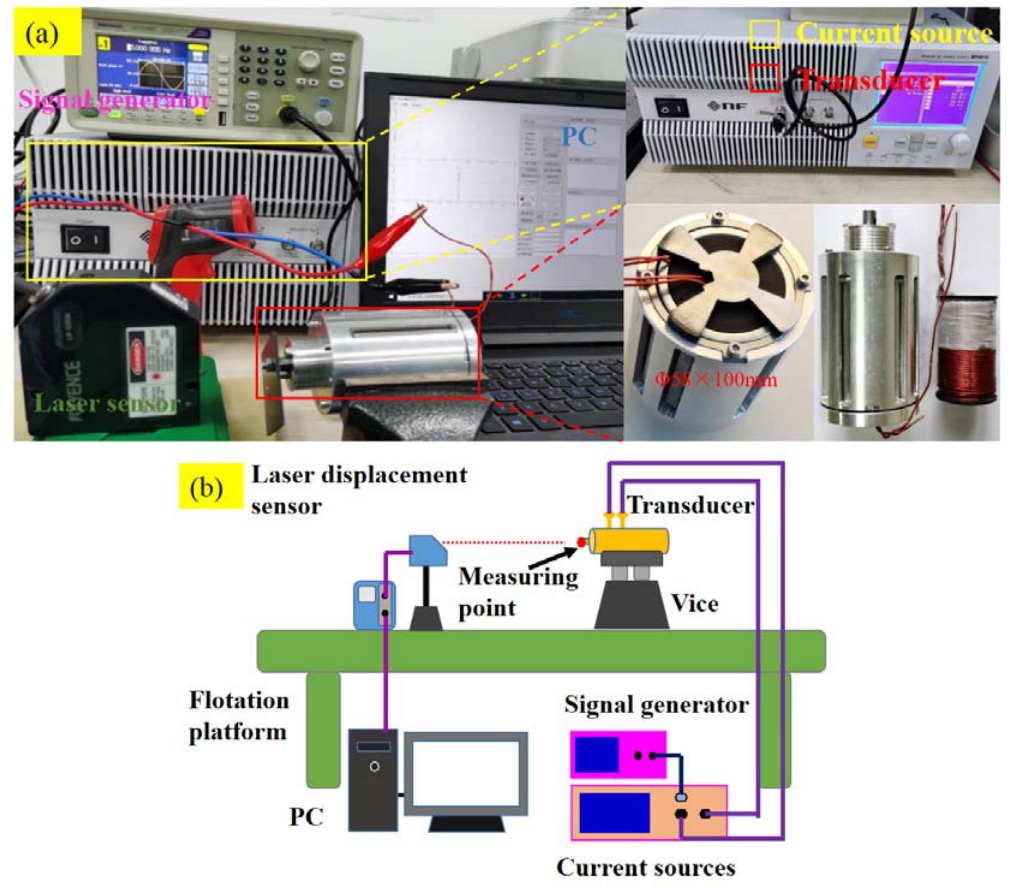
Figure 15. Experimental setup of the transducer: ( a ) experimental setup, ( b ) block diagram of the setup.